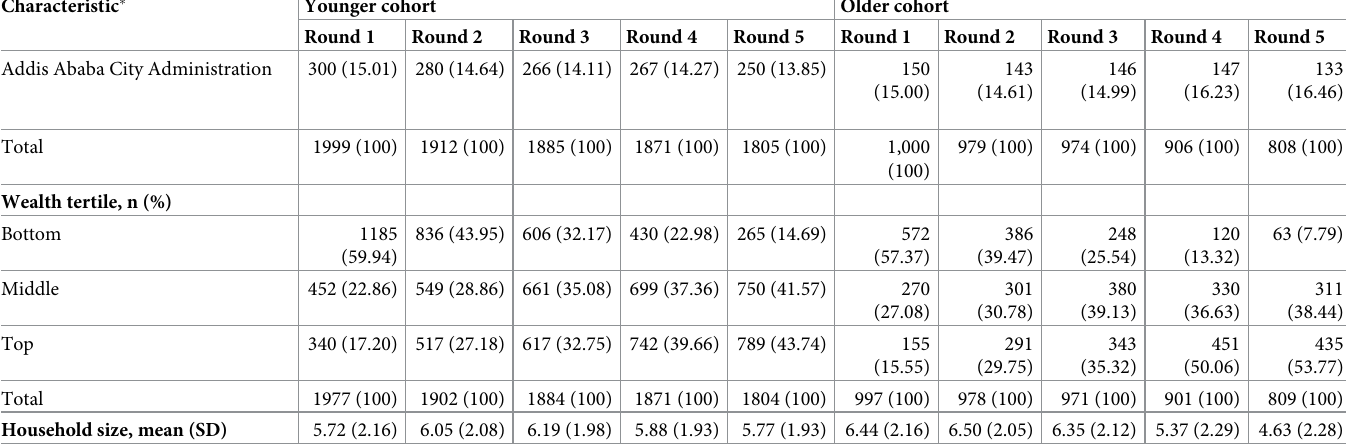
households of the bottom wealth tertile in Round